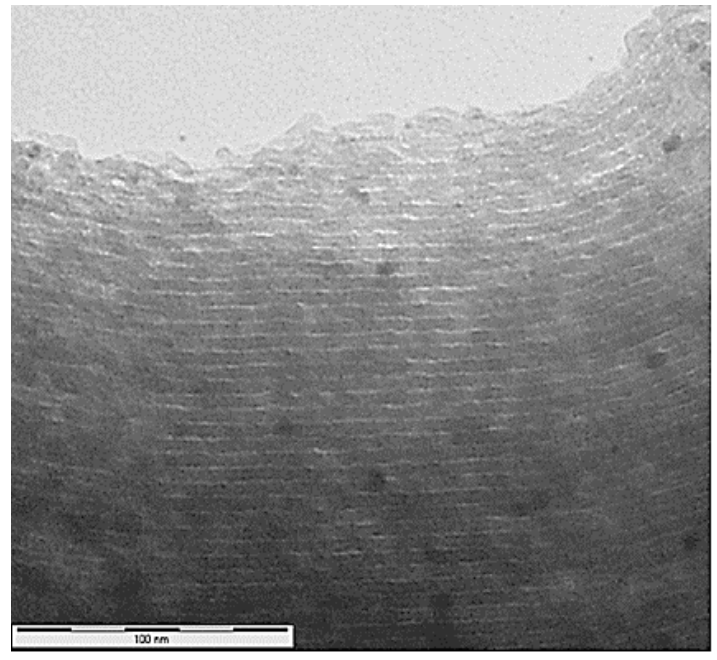
Figure 6. TEM image of Cu ‐ L@SBA ‐ 15.